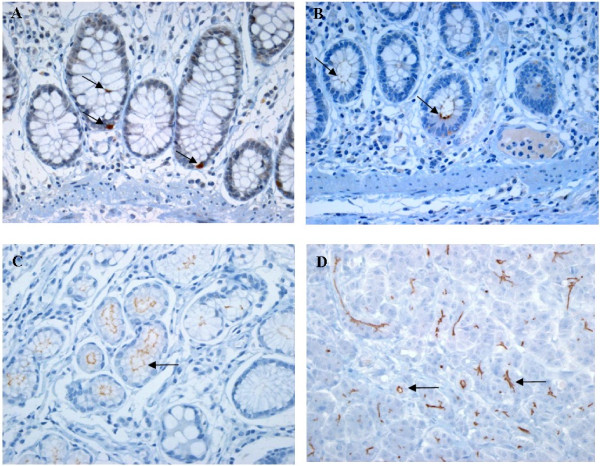
Photomicrographs of CD 133 IHC expression in non-neoplastic colonic mucosa in comparison with the non-neoplastic glands of stomach and pancreas. (A) CD133 positive cells are very rarely found in normal colon crypts and (B) along the luminal border of few crypts. (X 400 hematoxylin counterstained). In contrast to the colon, (C) the non-neoplastic pyloric glands and (D) pancreatic duct or acini show a distinct and diffuse staining in the luminal border. (X 200 hematoxylin counterstained).